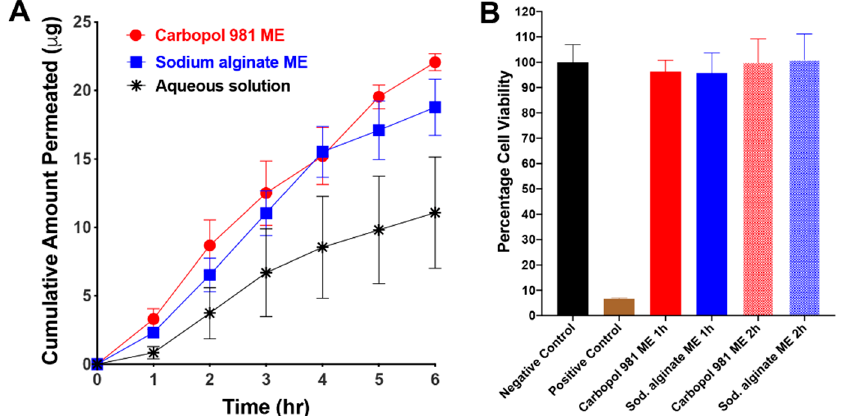
Table 3. In vitro transcorneal permeability parameters of ribavirin from Carbopol 981, sodium alginate MEs and an aqueous solution as a control.